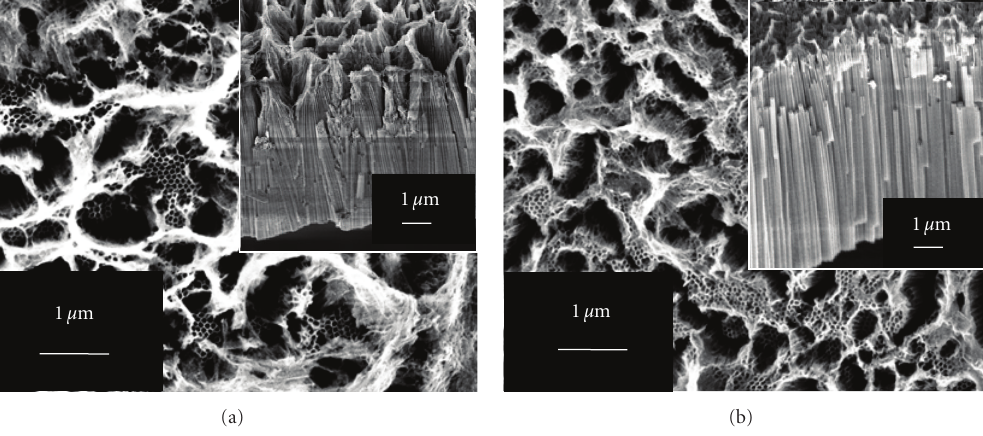
Figure 7: FESEM images of TiO 2 nanotubes obtained via di ff erent cleaning methods after the anodization process; (a) ultrasonically cleaned in distilled water for 1min and subsequently dried under flowing N 2 gas and (b) cleaned by hot rinsing at 90 ◦ C using distilled water for 1 min and subsequently dried under flowing N 2 gas.